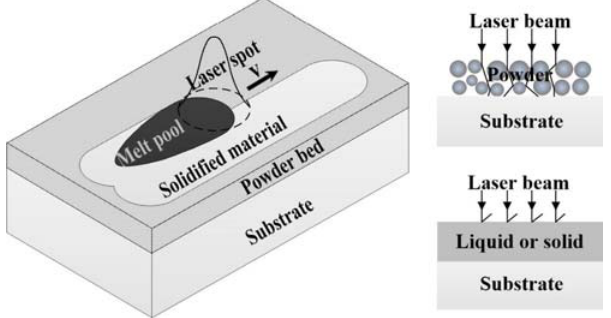
Figure 1. Schematic of absorption mechanism during laser metal powder bed fusion (PBF) process.